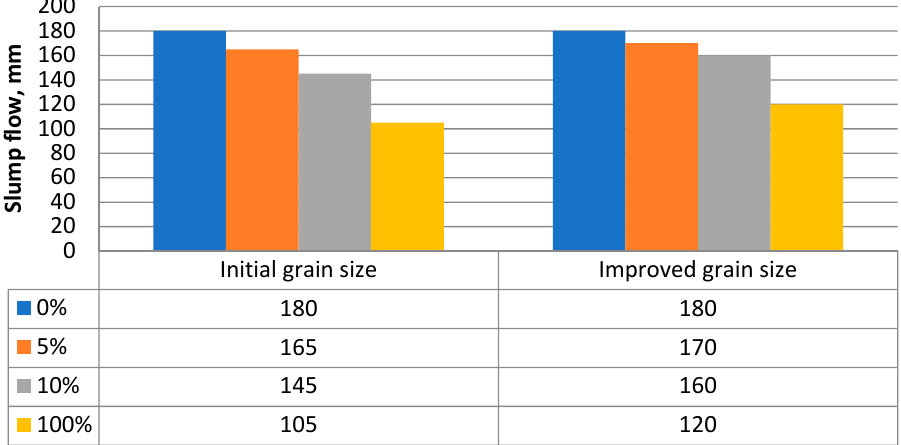
Figure 7. Effect of the rubber crumb on the workability of fresh mixtures.